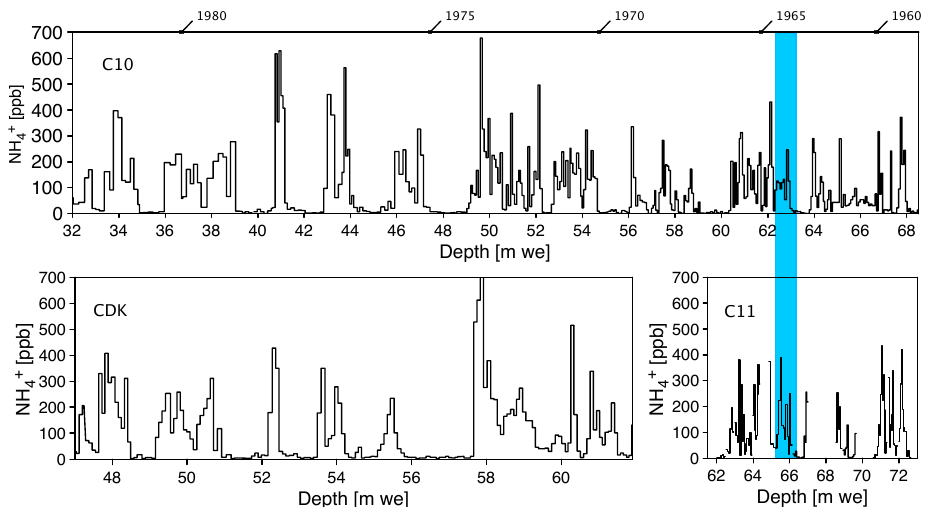
Fig. 1. NH + raw data from the C10 (top), CDK (bottom left) and C11 (bottom right) ice cores, illustrating the similar pattern of ion depth 4 profiles seen in the Col du Dˆome ice cores. The blue zone refers to the depths corresponding to the bomb test maximum horizon of 1963 detected in the C10 and C11 ice